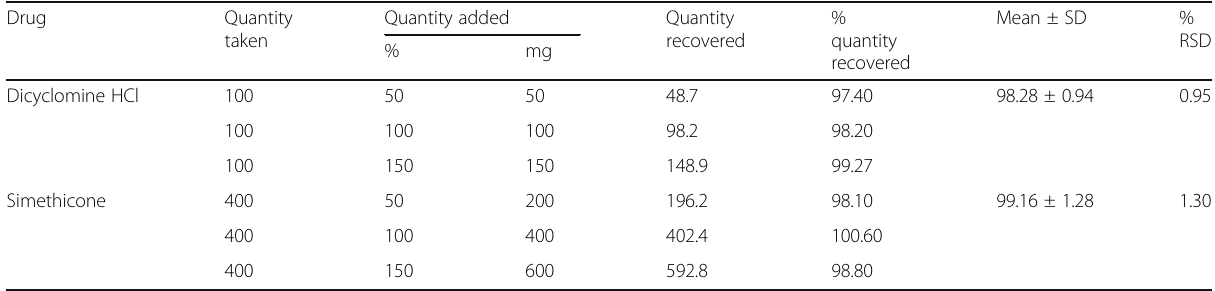
Table 3 Accuracy or recovery study of Dicyclomine HCl and Simethicone for developed analytical method